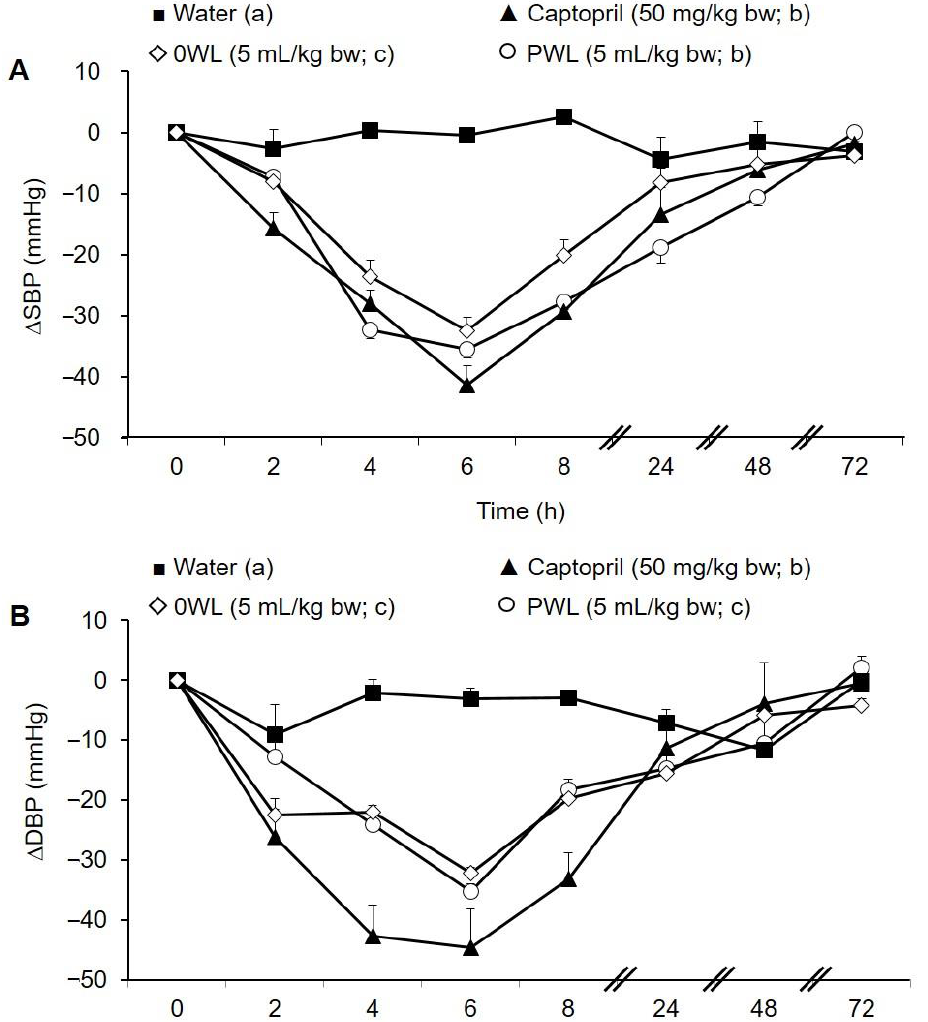
Figure 4. Changes in systolic ( A ) and diastolic ( B ) blood pressure (SBP and DBP, respectively) in spontaneously hypertensive rats after the administration of the following: water ( (cid:4) ), Captopril (50 mg/kg bw; (cid:78) ), control wine lees (5 mL/kg bw; 0 WL ♦ ), and phenolic-enriched wine lees (5 mL/kg bw; PWL ). Data are expressed as the mean ± SEM (n = 6). Different letters in the legend represent significant differences ( p < 0.05). p was estimated by two-way